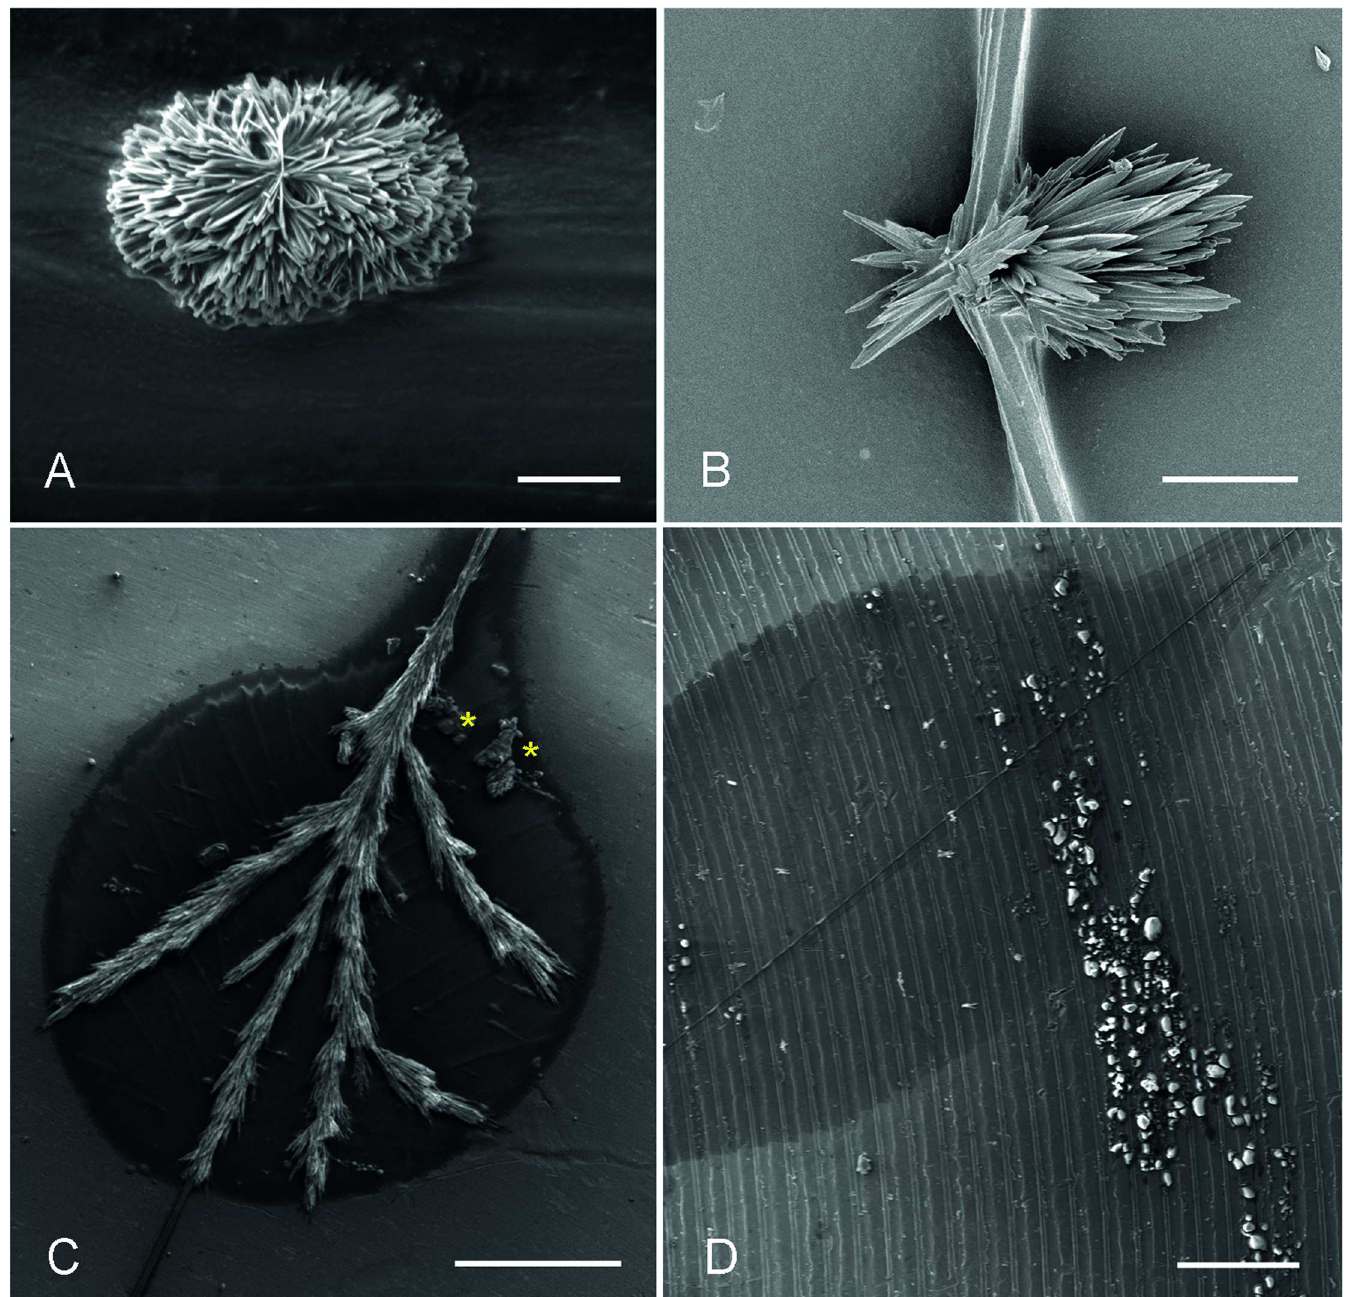
Fig 8. In the scanningelectron microscopethe crystalin-like core of the normalthread droplet in A . luminosa appears A) as rosettes or B) sheet-shaped pointedbundle,when pre-driedin the desiccation chamberbefore attachment on stubs. C) Samples, attached to polishedaluminum stubs and subsequently dried in the desiccationchamber; the crystals grow needle-shaped along the thread and form lateral branches. In additionto the crystal at the centre of the droplet, a non-crystalline content (yellowasterisks) could be observed at the base of the droplet. D) Samples, freshly attached to a riffled stub and air-dried; no crystal formation within the droplet area could be observed. Scale bar in A = 10 μ m; B = 5 μ m; C and D = 200 μ